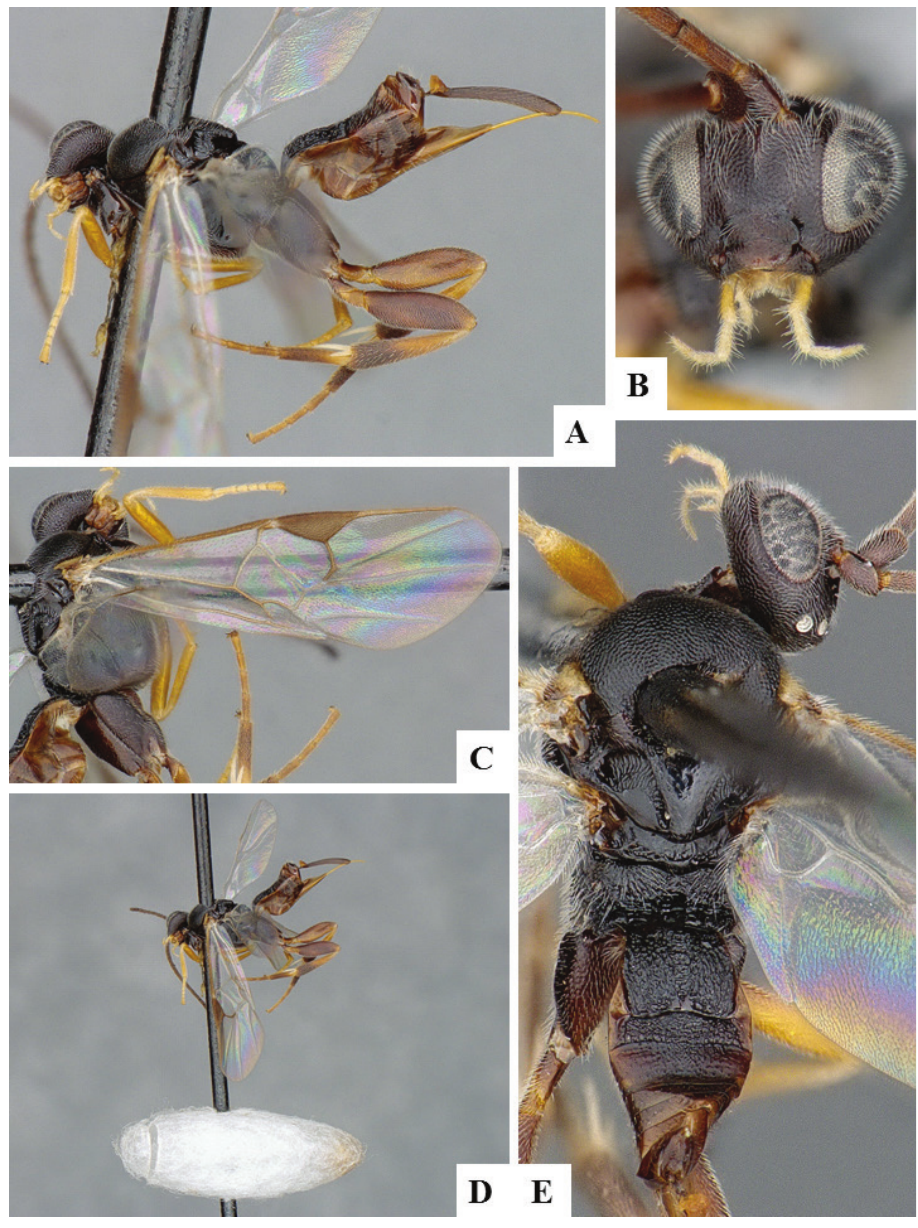
Figure 7. Apanteles jenniferae. A Habitus, lateral B Head, frontal C Wings D Adult wasp and its cocoon E Habitus,